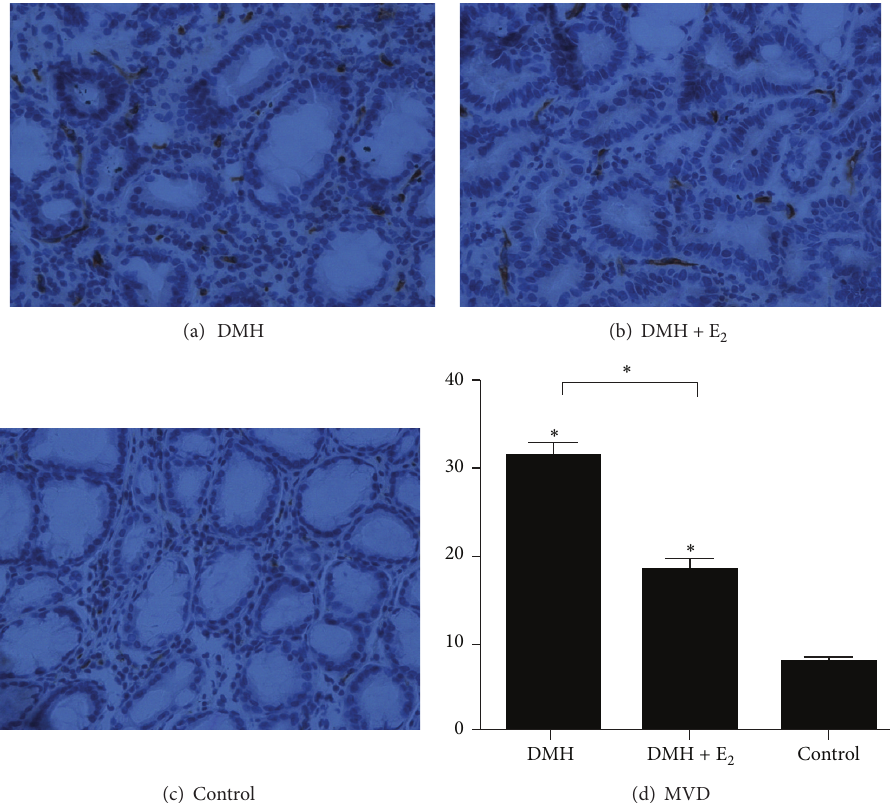
Figure 3: The MVD in each group. (a) Representative CD34 staining in polyp from the DMH group ( × 400 magnification). (b) Representative CD34 staining in polyp from the DMH + E 2 group. (c) Representative CD34 staining in normal colonic mucosa from the control group. (d) Comparison of MVD in different groups ( ∗ 𝑃 < 0.05